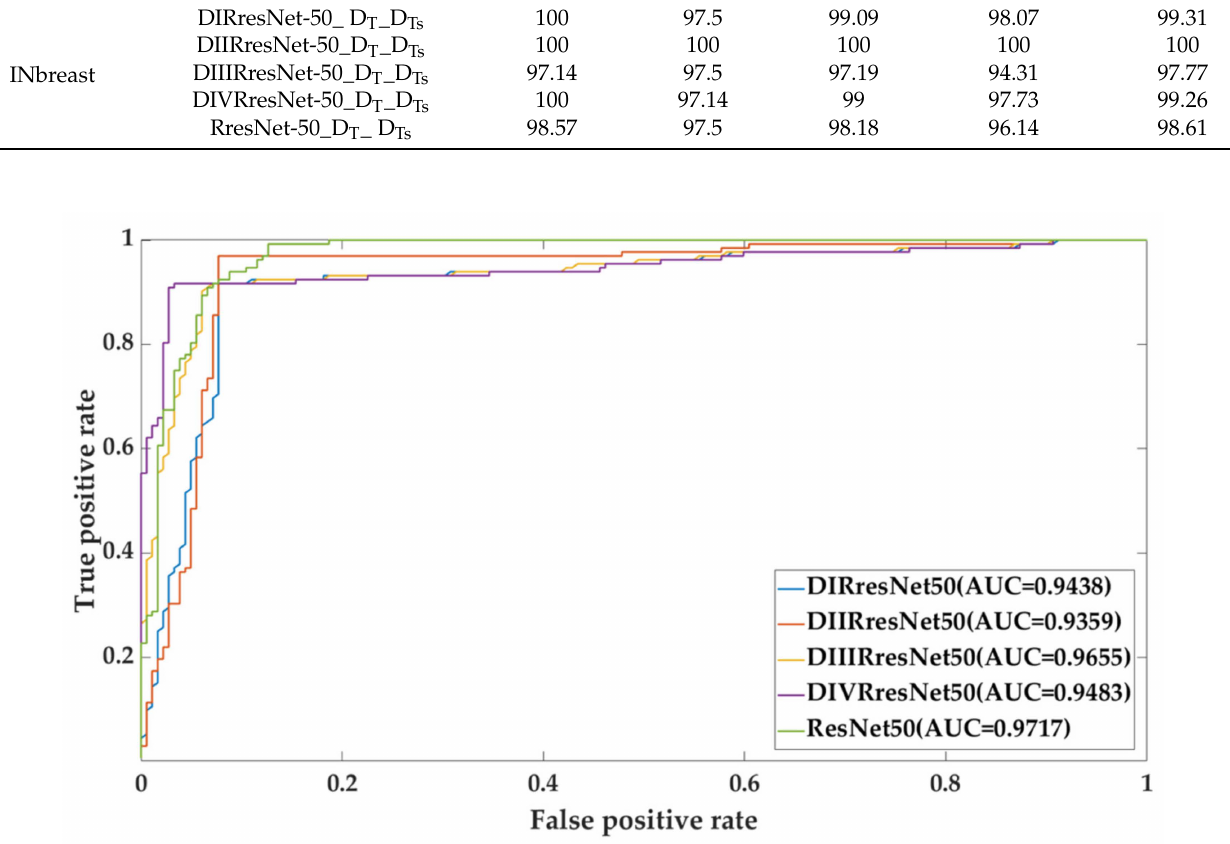
Figure 14. CBIS-DDSM ROC curve for the effect of density-specific models and